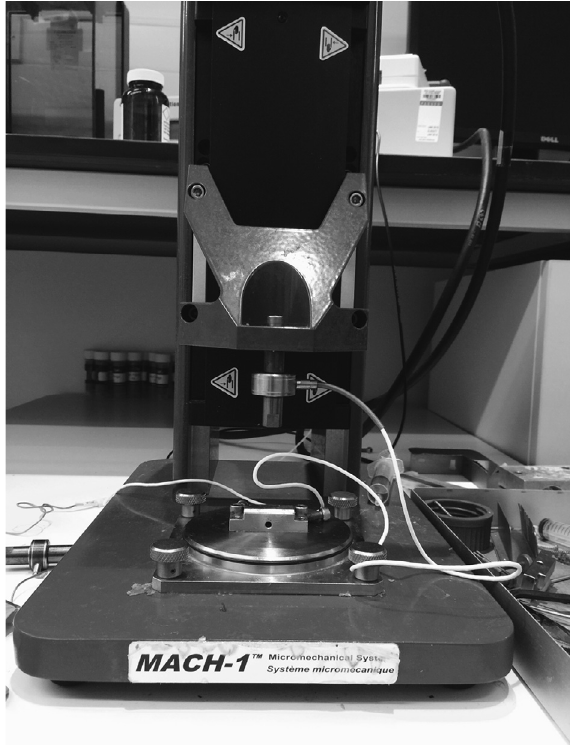
Figure 1. The MACH-1 Materials Testing Device, Biomomentum, Canada.